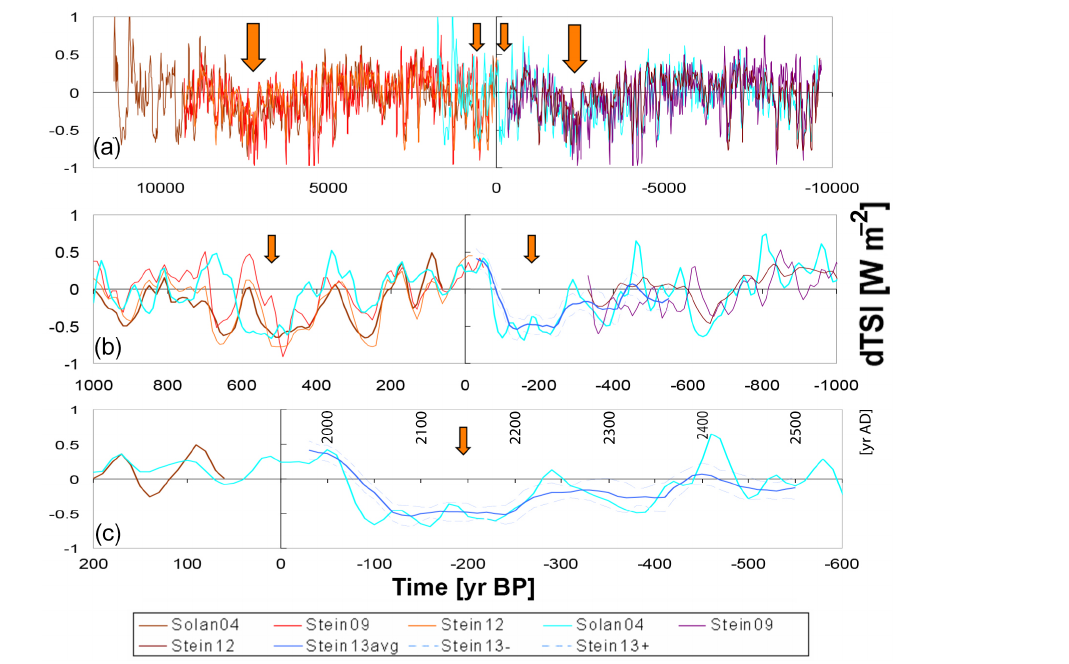
Figure 4. Solar activity signals reconstructed and modeled records. (a) Solar activity, TSI, reconstructed by Solanki et al. (2004), Steinhilber et al. (2009, 2012) (S04, S09 and S12, respectively), shown in Fig. 1a, and their analogue models. (b) A zoom of (a) that covers only 2kyr. (c) Another greater zoom of (a) that covers only 0.8kyr including the independent TSI forecast by S13. Big and small vertical arrows indicate super and grand solar